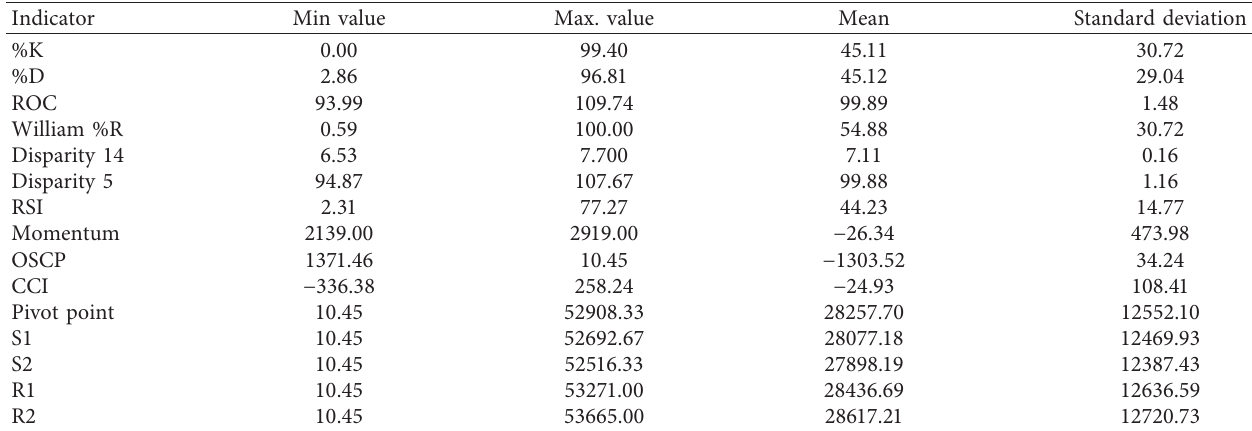
Table 2: Summary statistics of technical indicators for KSE-100